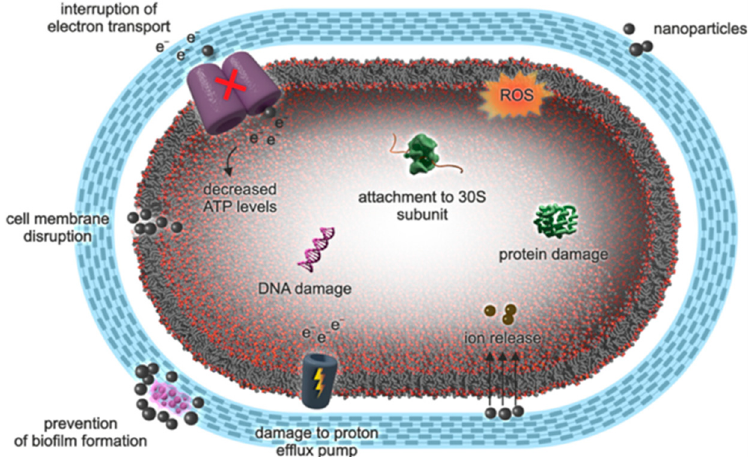
Figure 6. Mechanism of antimicrobial action of nanoparticles. (Reproduced with the permission from Ref. [118]. Adapted from Hochvaldová et al. (2022) under the Creative Commons CC BY license.)